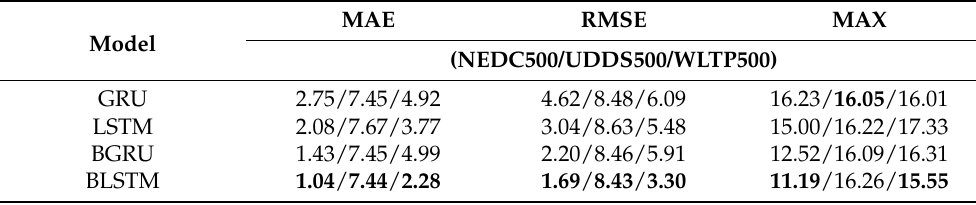
Table 4. The statistical results of scenario